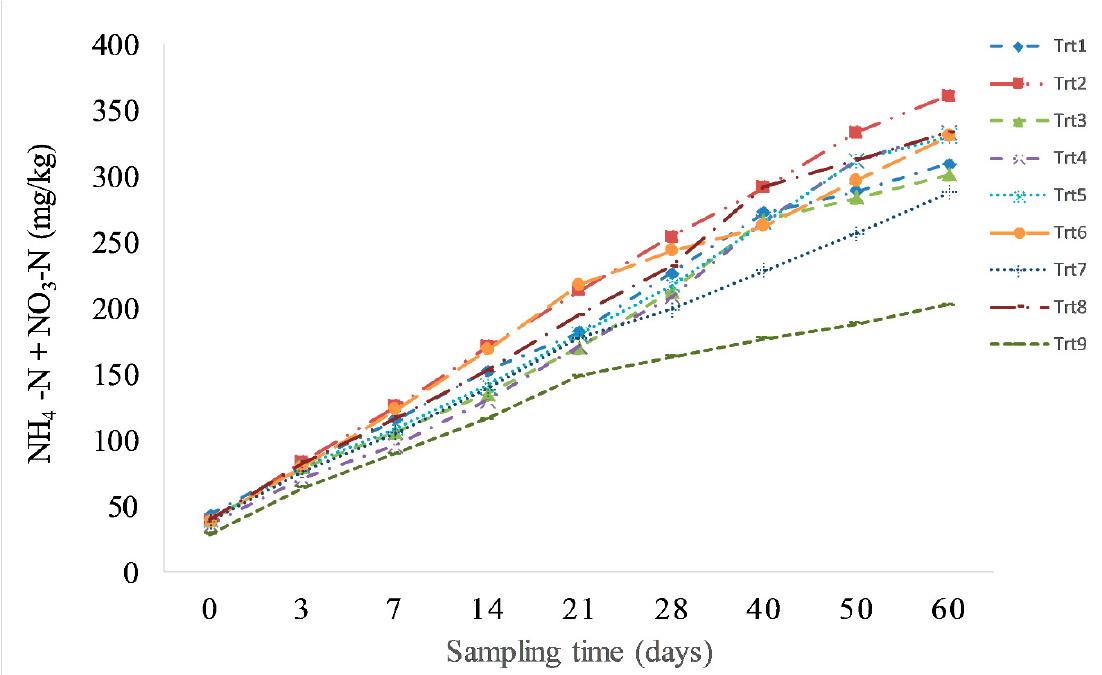
Figure 8. The cumulative NH 4 -N and NO 3 -N nitrogen in soils during incubation at different rates of